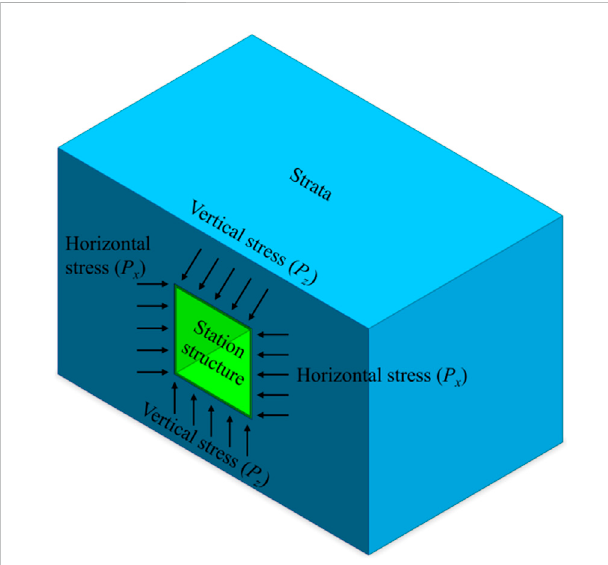
FIGURE 16 Stress distribution in the fi rst “ opening construction ” .